Question: Does the figure show an increasing or a decreasing trend?
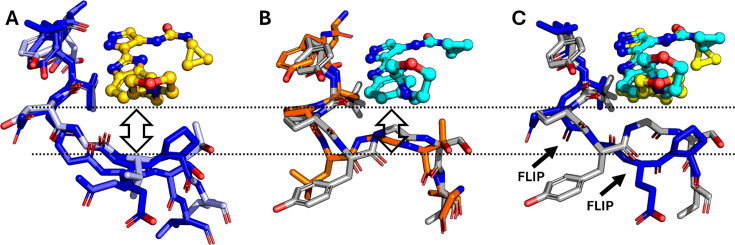
Answer: increasing